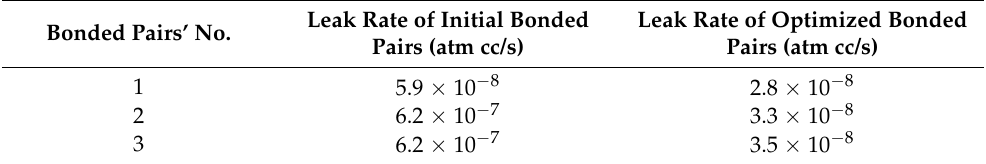
Table 3. The leak rate of initial and optimized bonded pairs. Bonded Pairs’